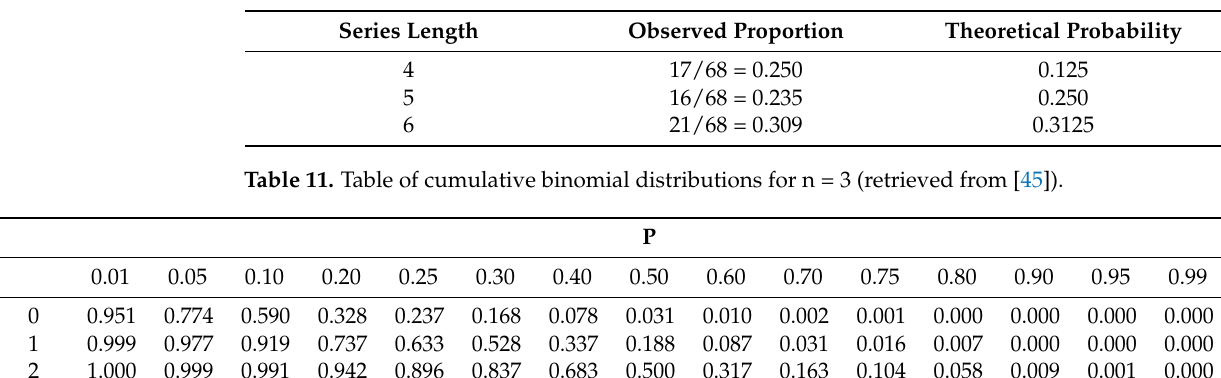
Table 10. Comparison table of theoretical probability and observed ratios in a binomial situation ending with 4 successes or 4 failures, considering p = q (retrieved from [44]).